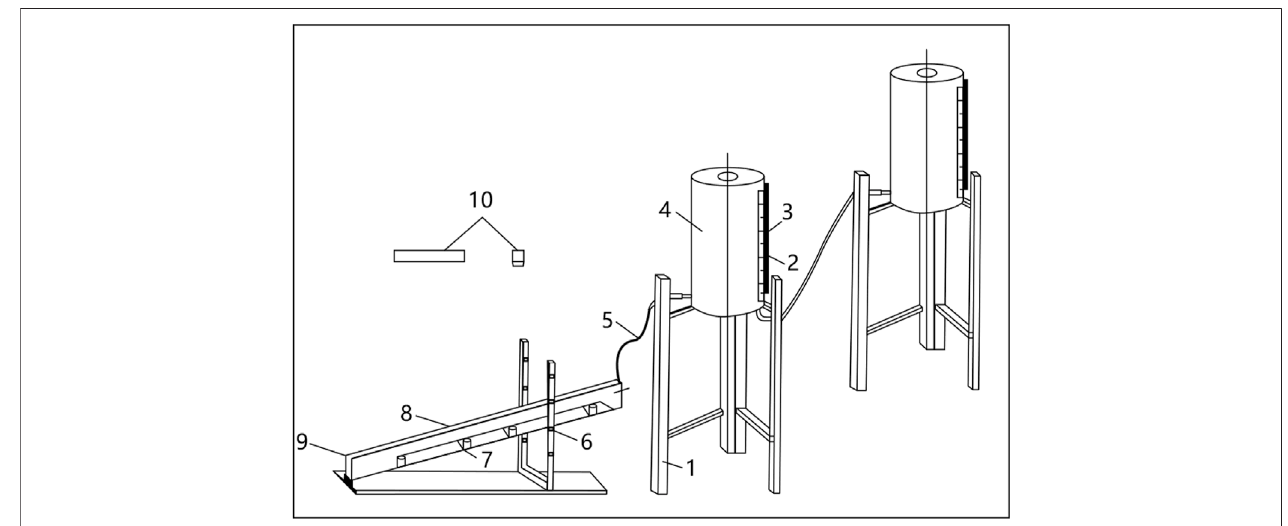
FIGURE3| Schematicdiagram ofanti-scouring test equipment (Chenet al., 2014).1isabucket rack; 2isascale ruler;3isaglass tube; 4isabucket; 5isawater pipe;6isastillwaterchamber;7isaskid;8isthe fl umeforthetest;9isthesiteforputtingthesamples;10isthecuttingringwith200 cm 3 (10 cmlength,5 cmwidth,and 4 cm